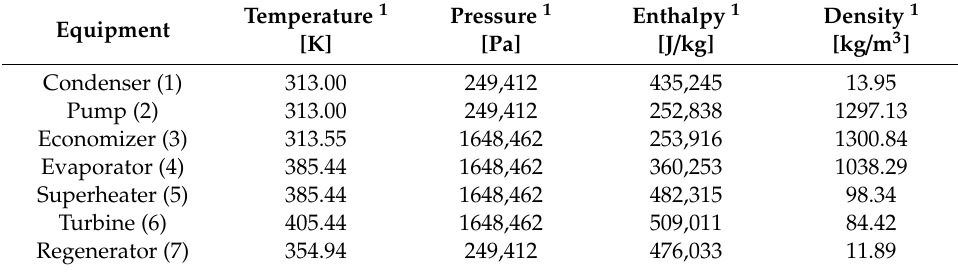
Table 4. R245fa thermodynamic parameters.